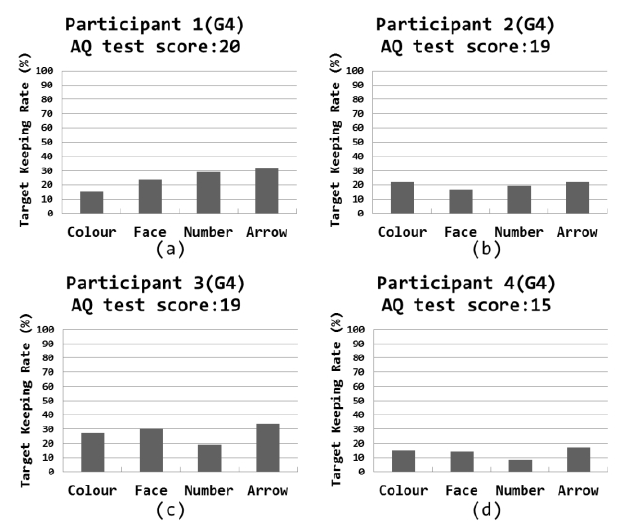
Figure 10. TKR of the participants in Group 4 (Average for most of the pop- ulation; a control group). (a) Participant 1(G4), female, AQ score: 20; (b) Participant 2(G4), male, AQ score: 19; (c) Participant 3(G4), female, AQ score: 19; (d) Participant 4(4), male, AQ score: 15.